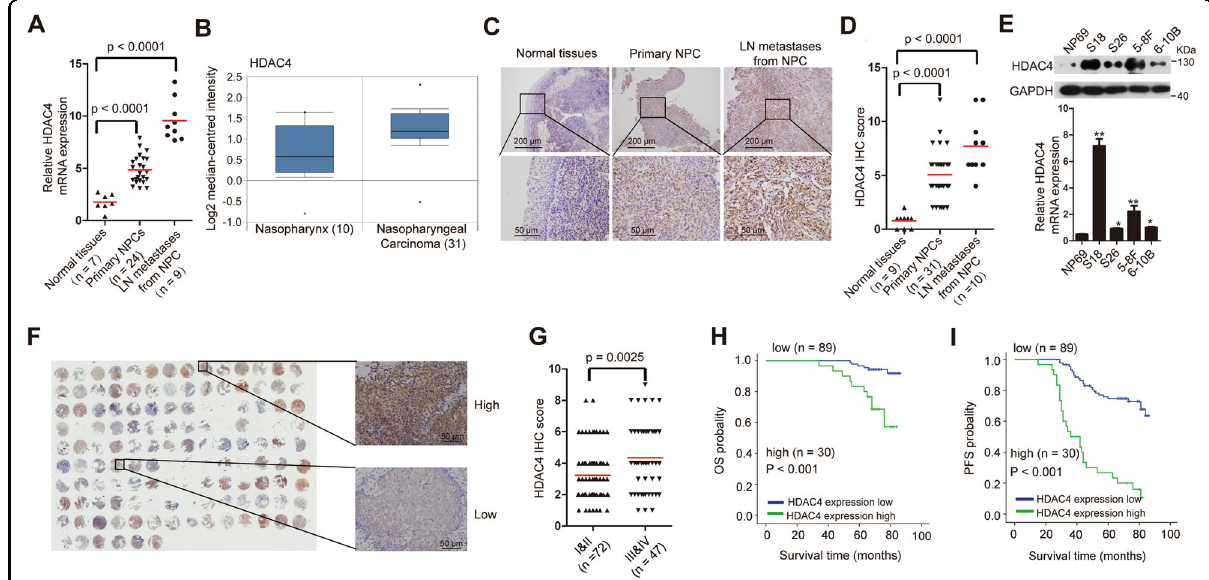
Fig. 1 HDAC4 expression increases in primary and metastatic NPC cells, and high HDAC4 expression predicts a poor clinical survival. A qRT-PCR analysis of HDAC4 expression in normal nasopharyngeal epithelial tissues ( n = 7), primary NPC tissues ( n = 24), and lymph node (LN) metastatic tissues from NPC ( n = 9). GAPDH was used as an internal control. The bars indicate the mean values. Student ’ s t -test, P < 0.0001. B Analysis of human HDAC4 expression in normal nasopharyngeal epithelial tissues and NPC tissues using the Oncomine database (http://www.oncomine.org). C , D IHC staining ( C ) and statistical analysis ( D ) of HDAC4 in normal nasopharyngeal epithelial tissues ( n = 9), primary NPC tissues ( n = 31), and lymph node (LN) metastatic tissues from NPC ( n = 10). Student ’ s t -test, P < 0.0001. Scale bar, 200 µm and 50 µm, respectively. E The relative mRNA and protein levels of HDAC4 in cell lines were determined by qRT-PCR and western blotting, respectively. GAPDH was used as a loading control. The data are presented as the means ± SD of three independent experiments. Student ’ s t -test, * P < 0.05, ** P < 0.01. F IHC staining for HDAC4 in 119 clinical NPC samples (left). The images on the right are representative images. G HDAC4 protein expression was assessed by IHC analysis of 72 samples with an NPC clinical stage of I – II and 47 with an NPC clinical stage of III – IV. The data are presented as means ± SD. Student ’ s t -test, P = 0.0025. Scale bar, 50 µm. H , I OS ( H ) and PFS ( I ) curves were generated based on the HDAC4 protein expression status of 119 paraf fi n-embedded NPC tumor tissues, P <